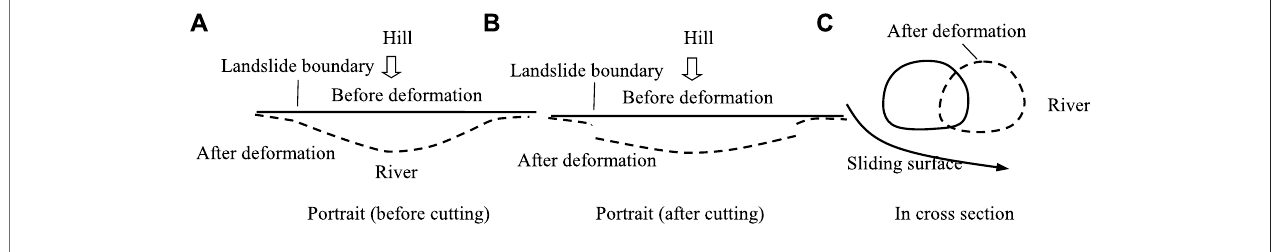
FIGURE 14 | Deformation diagram of the “ transverse ship ” mode.